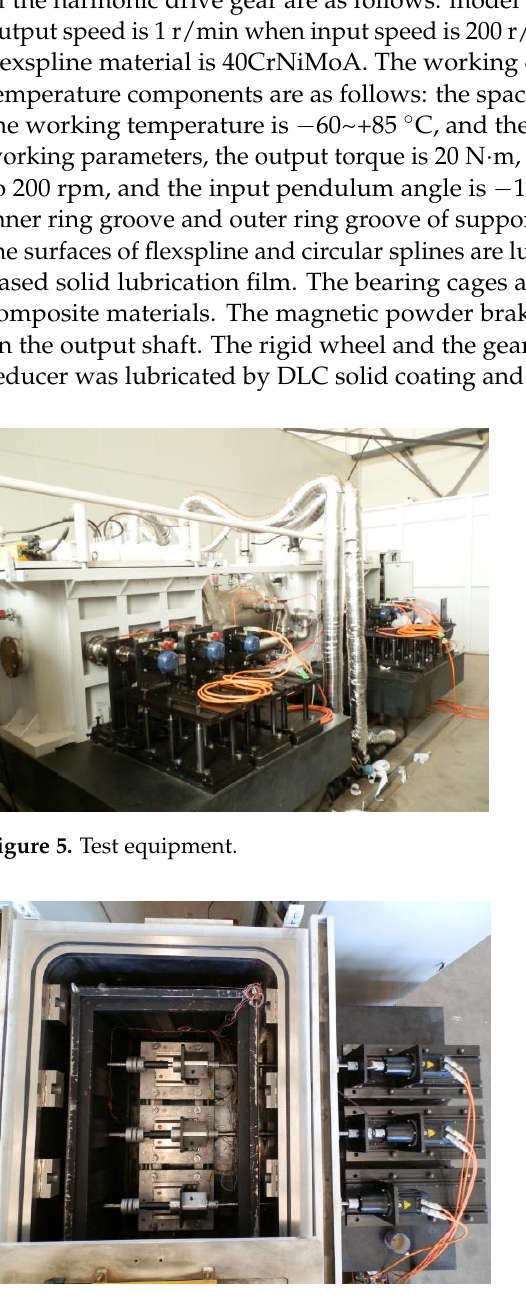
Figure 6. Internal